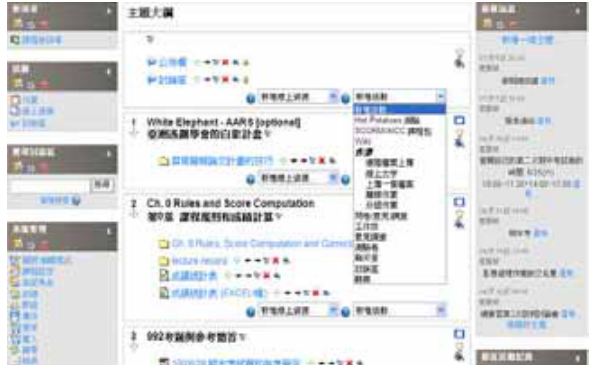
Figure 7. Functions for adding diversified activities on NCKU